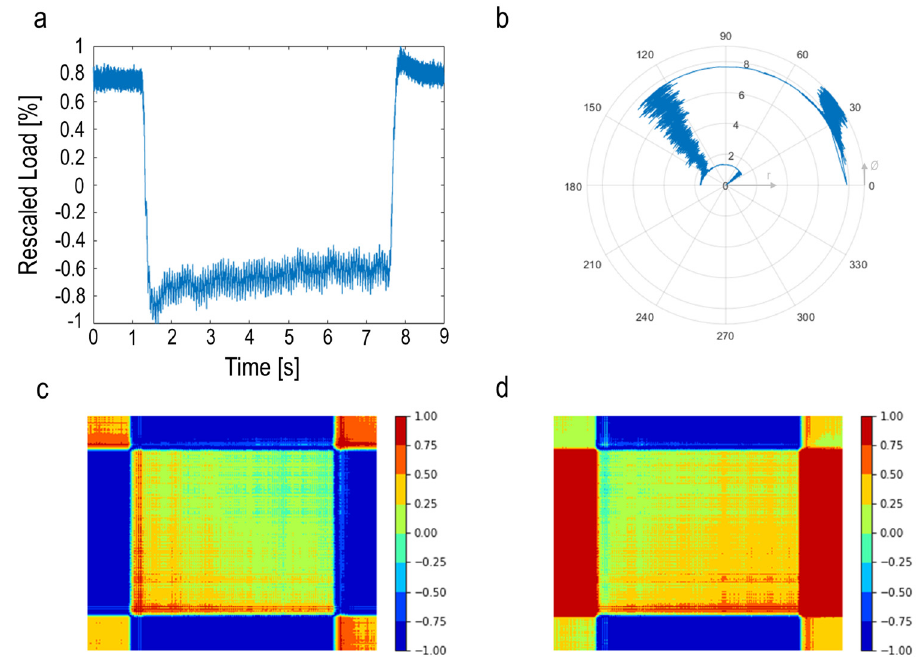
Figure 7. ( a ) Rescaled load signal; ( b ) polar coordinate mapping of signal; ( c ) Gramian angular summation field ( GASF ); ( d ) Gramian angular difference field ( GADF ).